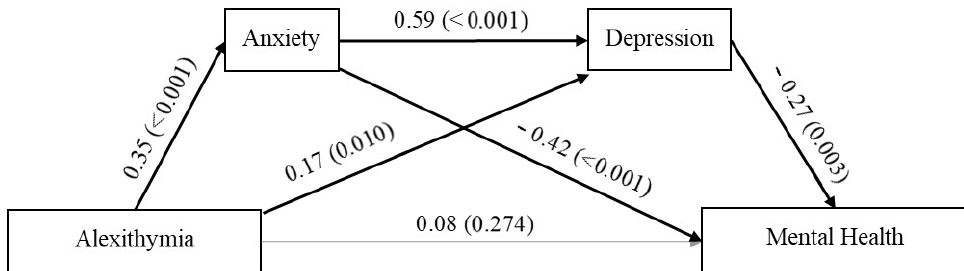
Figure 1. The mediating role of anxiety and depression in the relationship between alexithymia and mental health ( β , p ). Bold lines indicate significant mediation. Standardized coefficients are